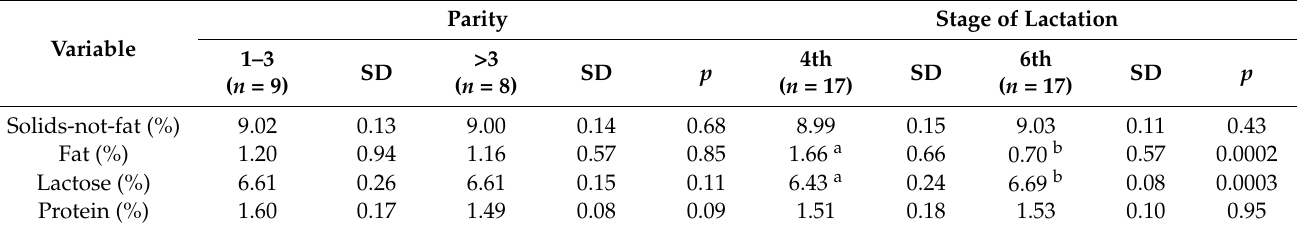
Table 4. Gross composition of mare’s